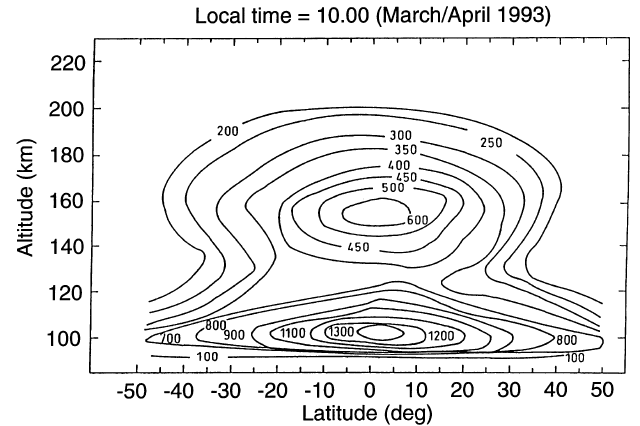
Fig. 8. The latitudinal variation of two monthly (March/April 1993) averaged volume emission rates as obtained from present model at 10 h